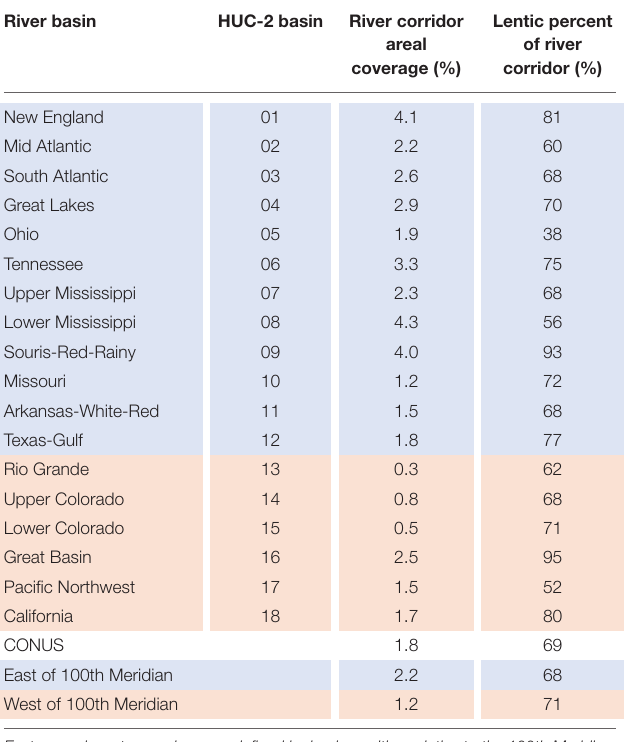
TABLE 1 | Surface water areal coverage of river corridor and lentic waterbody percentage summarized as total values for CONUS, eastern and western regions, and major HUC-2 river basins (delineations shown in Figure 2